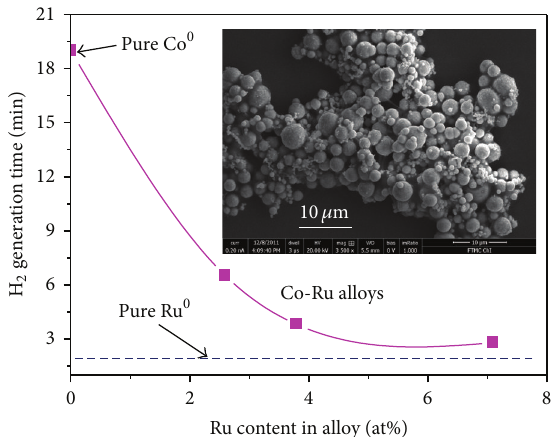
Figure 5: Variation of the time consumed for generation of half amount of H 2 gas from that theoretically calculated (47.4mL) when 0.4% NaBH 4 solution (5mL) was explored using 5mg of pure Ru 0 (dashed line), pure Co, and Co-Ru alloy catalysts at 30 ∘ C. Inset depicts an FESEM view of alloy